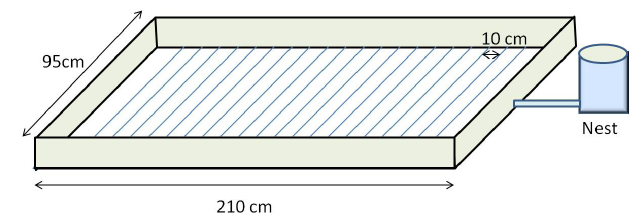
Fig 1 . Schematic drawing of the observation apparatus. The observer is positioned beneath the